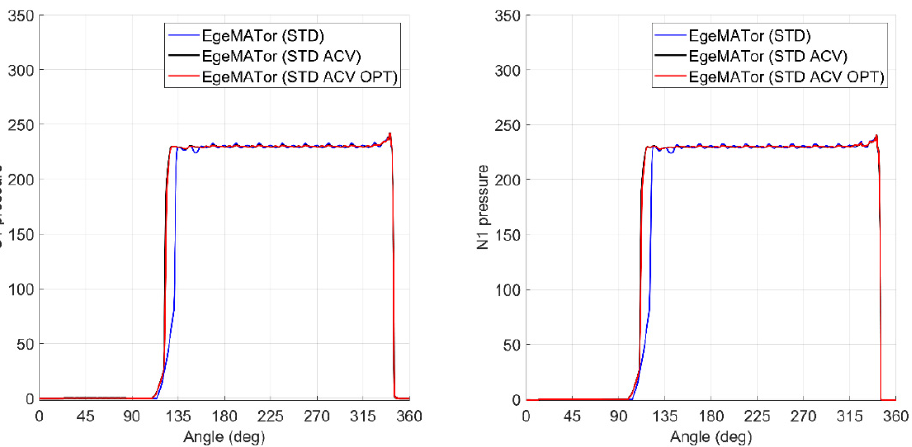
Figure 20. G i and N i pressure distributions.